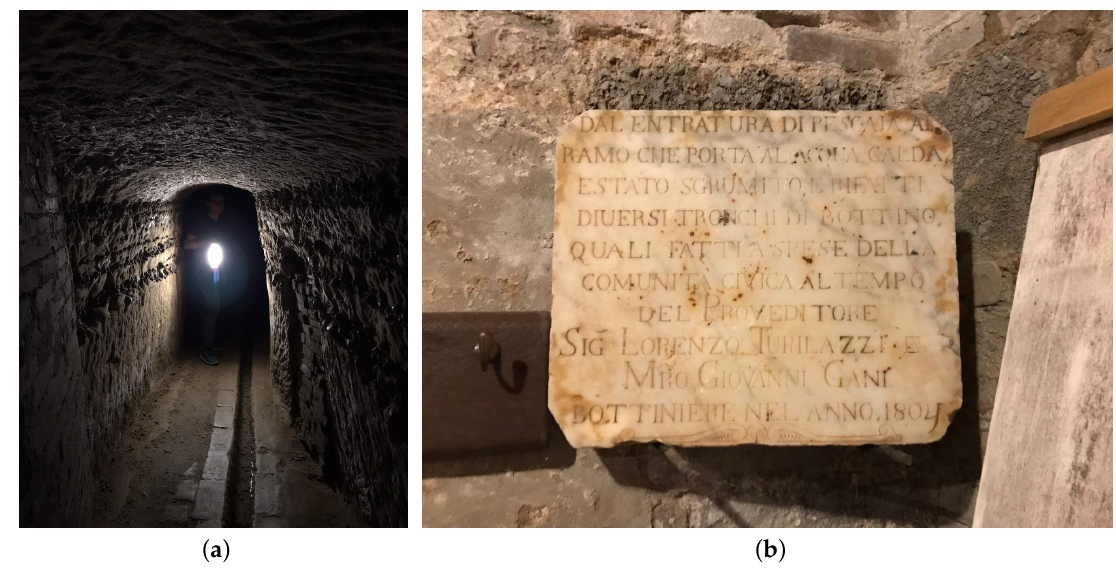
Figure 1. ( a ) A view of one of the “Bottini” galleries and ( b ) one of the historical